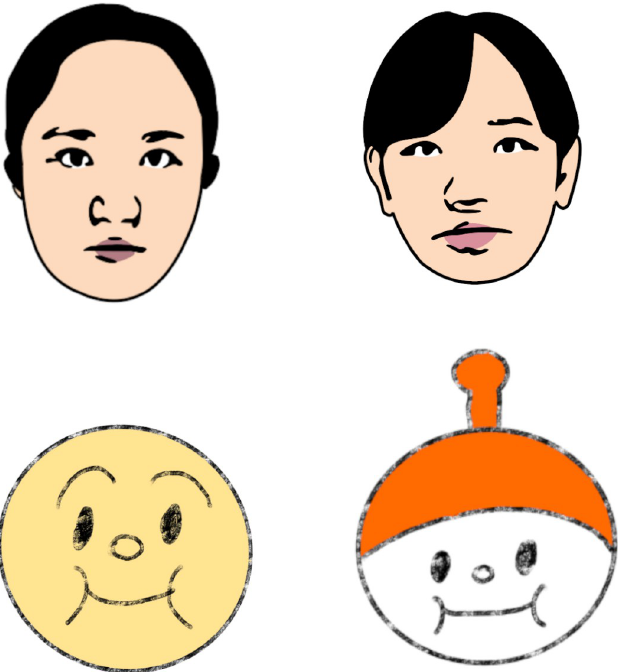
Fig 1. Examples of the cartoon female and character faces used as stimuli. Faces were presented on a gray background. The cartoon character face stimuli used in the experiment were different from the images in Fig 1. Because of the copyright, we used other character faces here, instead of the “ANPANMAN.” For details of the cartoon character face stimuli, see the Materials and Methods section in Experiment